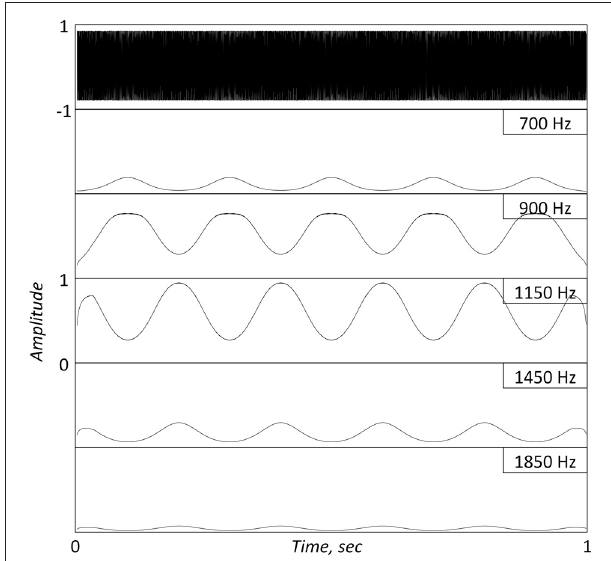
FIGURE 1 | Top panel. A 1s long FM stimulus with a 1KHz carrier, modulated by a 5Hz sinusoid. Bottom Panels : Simulated Inner Hair Cell (IHC) responses, low-pass filtered to 50Hz, at five successive center frequencies (CFs) surrounding the carrier location. The cochlear filters are modeled as linear gammatone filters and the IHC as a half-wave rectifier followed by a low-pass filter, representing the reduction of synchrony with CF. Note the re-generation of the modulating signal at the cochlear output.